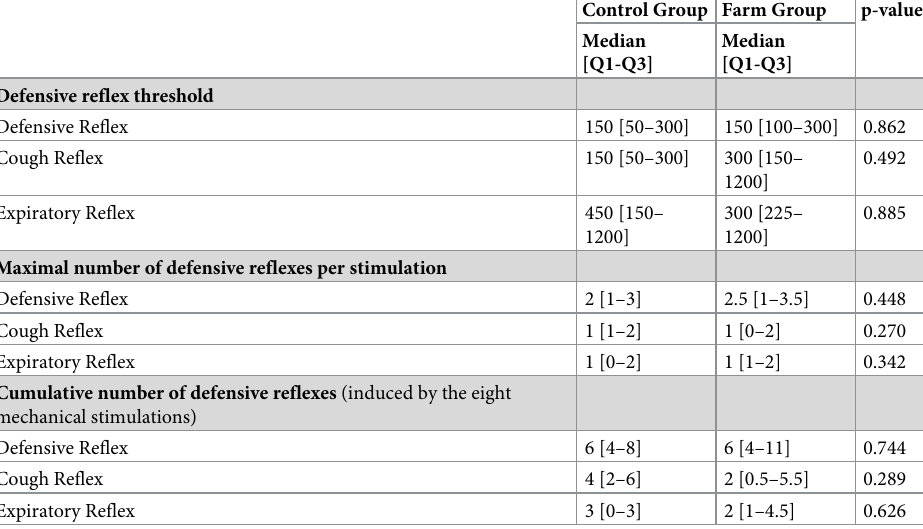
Table 2. Defensive reflexes induced by mechanical stimulation (threshold, maximal number, and cumulative number).